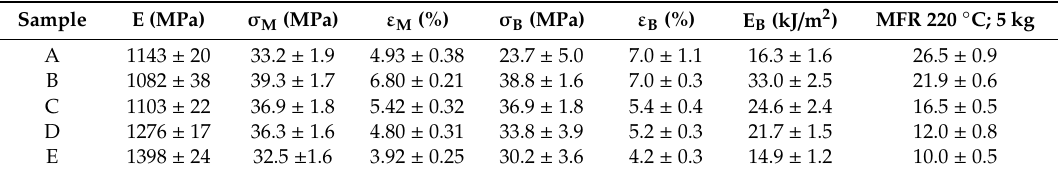
Table 4. Young modulus (E), tensile strength ( σ M ), strain at σ M, ( ε M ), tensile at break ( σ B ), strain at σ B